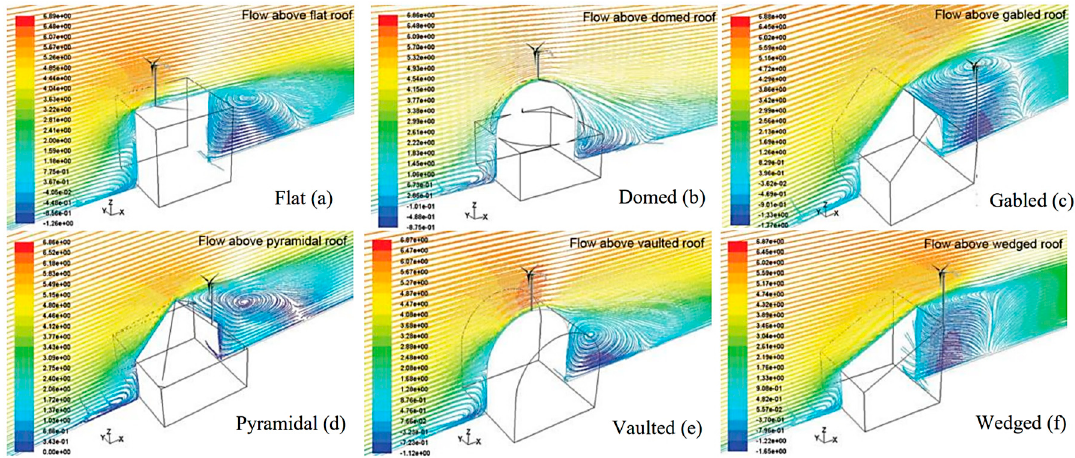
Figure 15. Vertical stream wise velocity path lines along the central plan for the investigated roof shapes [69]. roof shapes